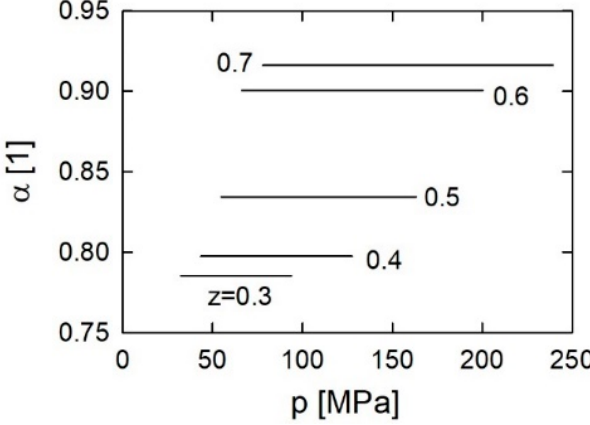
Figure 6. Values of the exponent α for chosen z values.